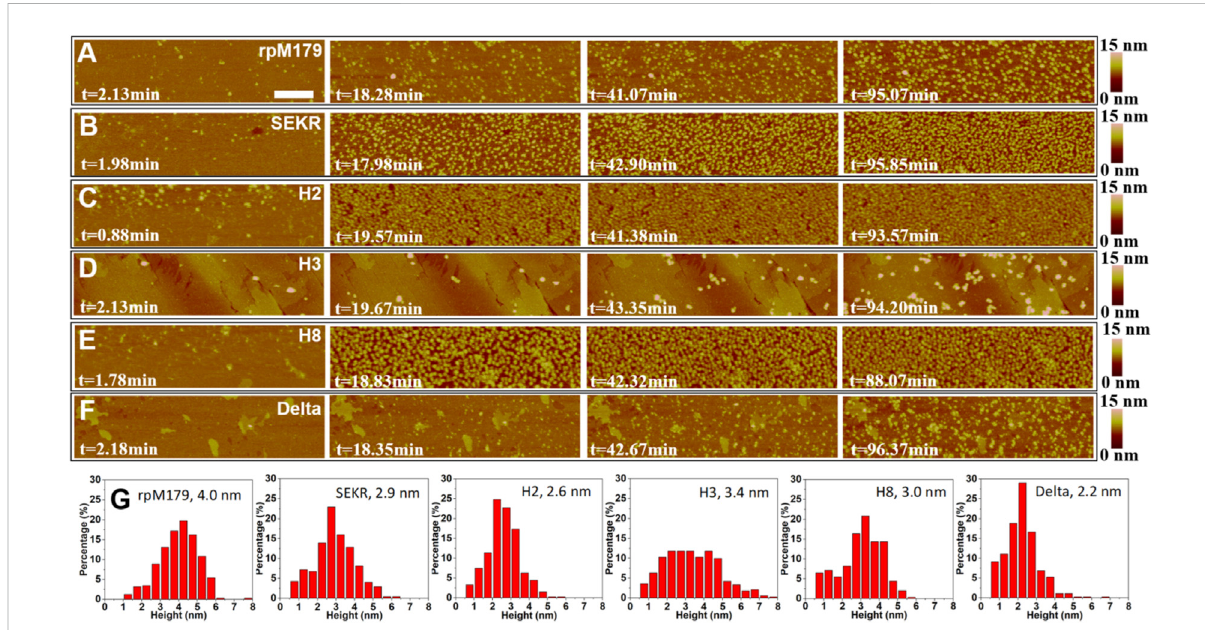
FIGURE 2 (A – F) In situ AFM images of adsorbates from 15.6 μ g/ml protein, 25 mM Tris one monolayer ofadsorbates. The zero point of time is de fi ned as thetime when protein solutions are injected into theAFM liquid cell. The scale bar is200 nm.Allthemicrographs arethesamesize. (G) Heightdistributionsoftheadsorbateswiththemeanheightshown inthelabel.Thesecond and third images in (A) were taken from Tao et al.,